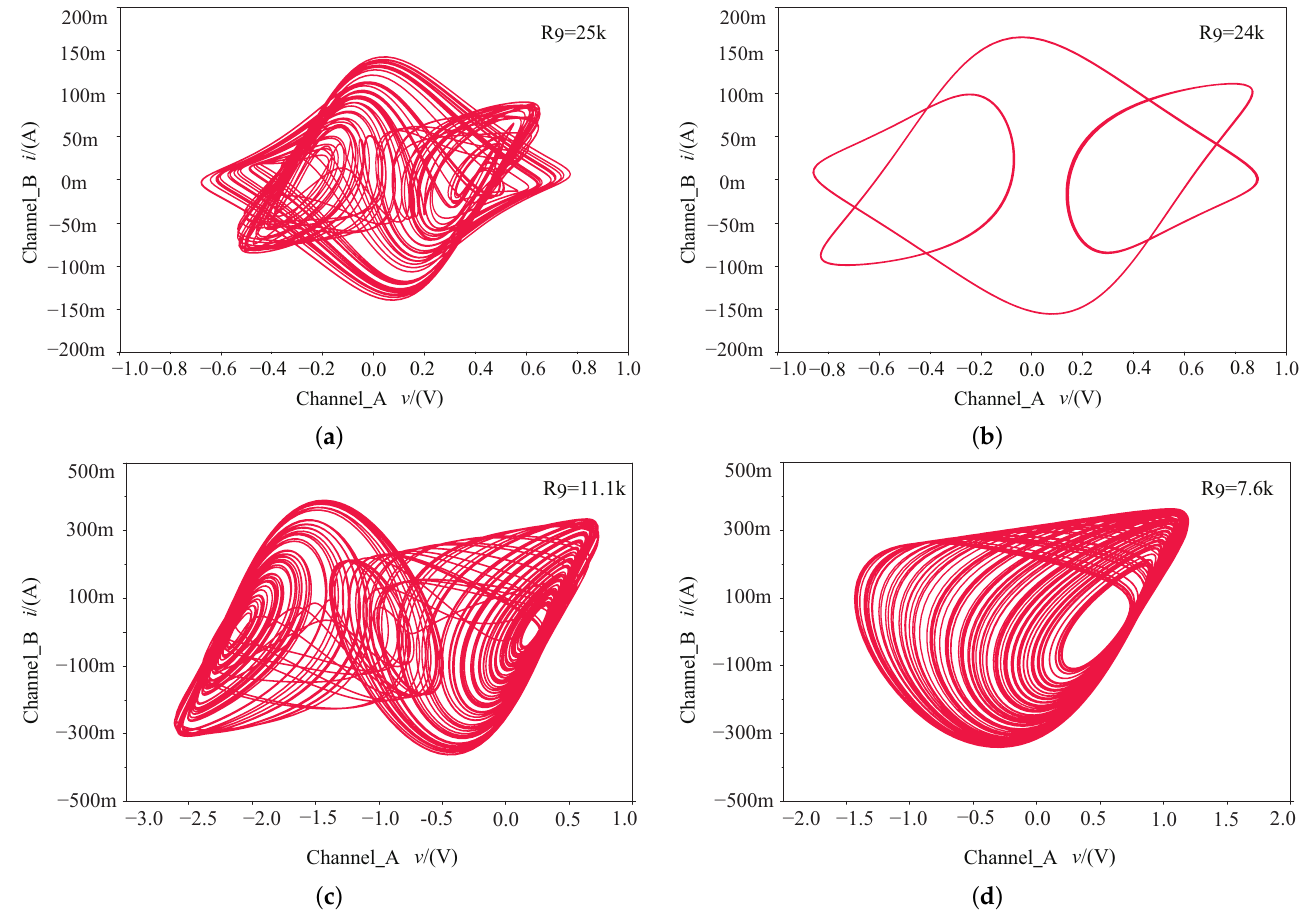
Figure 16. Circuit simulation under different resistances R 9 in x 1 1 limit cycle with R 9 = 4.3 k; ( b ) single-scroll periodic-2 limit cycle with R 9 = 5.8 k; ( c ) single-scroll chaotic attractor with R 9 = 7.6 k; ( d ) symmetric single-scroll chaotic attractor with R 9 = 11.1 k.